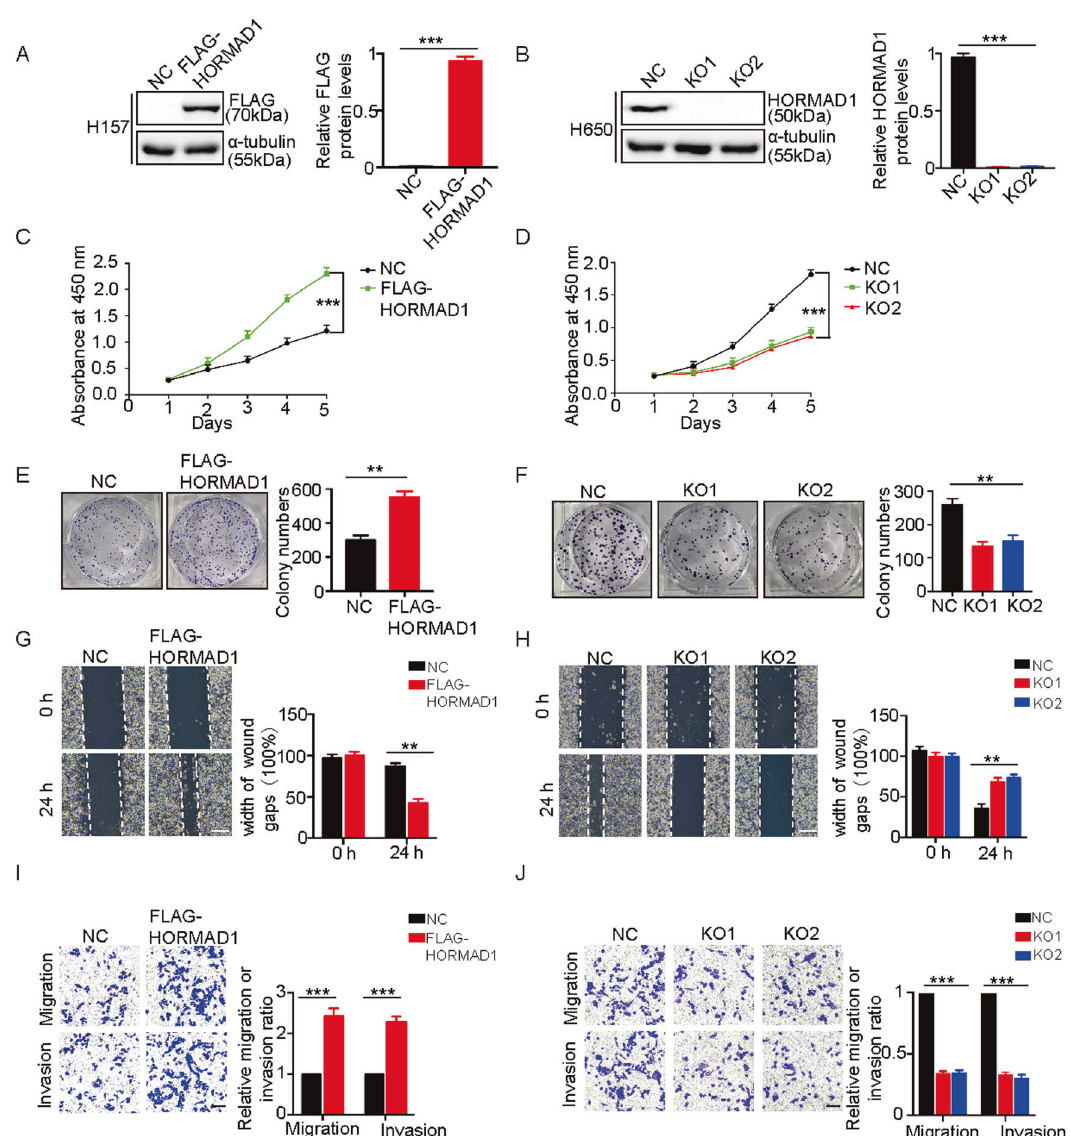
Fig. 2 HORMAD1 promotes the proliferation, migration, and invasion of lung cancer cells in vitro. A Western blotting and quantitative analyses of HORMAD1 expression in H157 cells with or without HORMAD1 expression. α -tubulin was used as the loading control. B Western blotting and quantitative analyses of HORMAD1 expression in HORMAD1 negative control (NC) and KO H650 cells. α -tubulin was used as the loading control. The proliferation of H157 cells with or without HORMAD1 expression ( C ) and NC and HORMAD1 KO H650 cells ( D ) was measured by CCK-8 assays at the indicated time points. The colony-forming ability of H157 cells with or without HORMAD1 expression ( E ) and NC and HORMAD1 KO H650 cells ( F ) was measured by colony formation assays. The migration of H157 cells with or without HORMAD1 expression ( G ) and NC and HORMAD1 KO H650 cells ( H ) was evaluated by wound healing assays; the scale bars are 200 μ m. The cell migration and invasion of H157 cells with or without HORMAD1 expression ( I ) and NC and HORMAD1 KO H650 cells ( J ) was examined by Transwell assays; the scale bars are 100 μ m. All histograms representing indicated the results of three independent experiments. Mean ± SEM from three independent experiments are shown. ** p < 0.01; *** p < 0.001. Cell Death Discovery (2022)